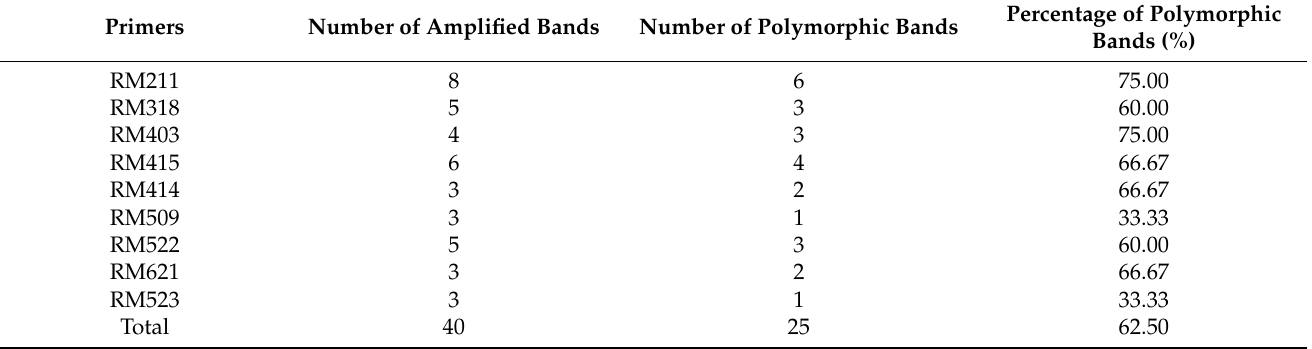
Table 3. Polymorphism of SSR primer amplification bands of Ustilaginoidea virens isolates.